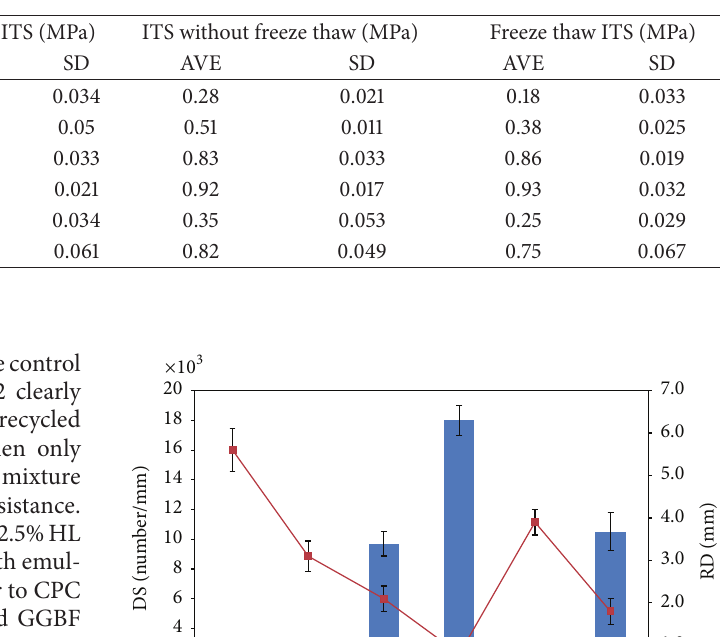
Table 5: Results of moisture susceptibility tests (three replicates).